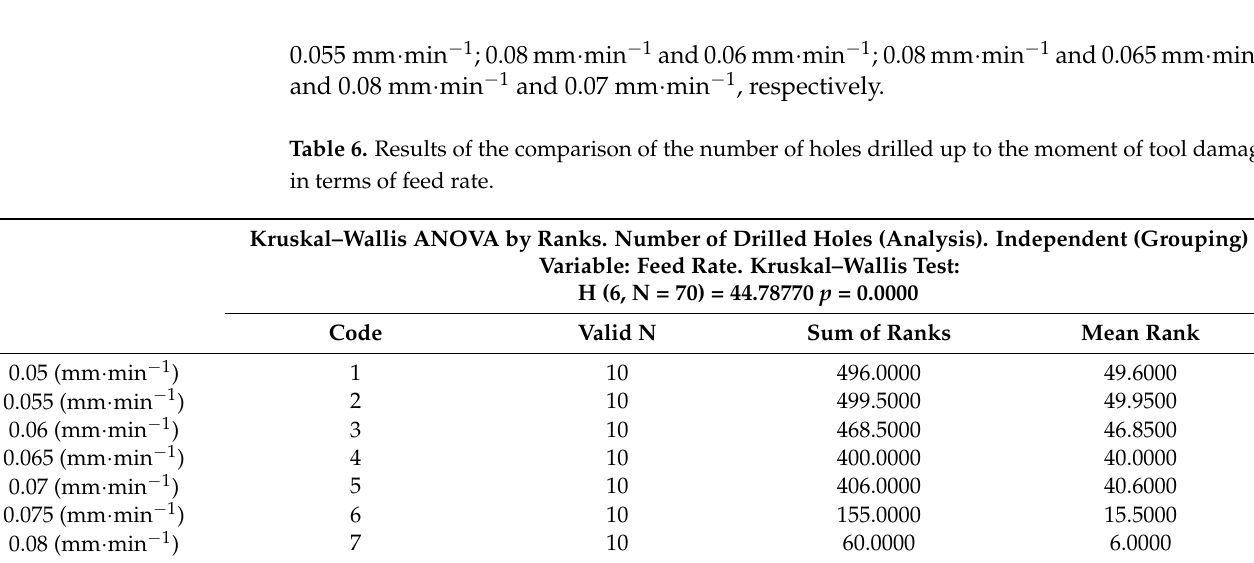
Table 7. Results of multiple comparison of p values of the number of holes drilled up to the moment of tool damage in terms of change in the feed rate.